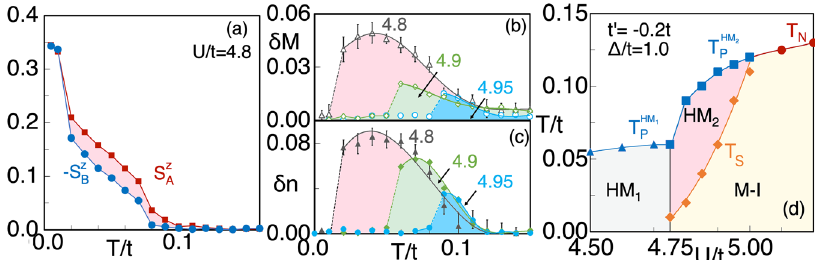
Fig. 3 Magnetism & U − T phase diagram. a It shows the sub-lattice magnetizations S z A and S z B for U / t = 4.8. b , c Show the difference in sub-lattice local moments ( δ M ) and the total spin polarization of the system ( δ n ) respectively, for U / t = 4.8 4.9 and 4.95. In each case, the dashed lines between two temperature points indicate the location of the onset temperature for half-metallicity. d This shows the U − T phase diagram with a low-temperature antiferromagnetic half-metal HM 1 to antiferromagnetic Mott insulator (M-I) transition at U M = 4.75 t . Triangles indicate T P , the depolarization temperature of half metallicity for HM 1 . The red shaded region refers to the fi nite-temperature ferrimagnetic half-metal HM 2 for U M < U < 5 t and bounded by the onset temperature of polarization T S and the depolarization temperature T P . The T S ( T P ) scales for HM 2 are demarcated by diamonds (squares). Circles refer to T N , the temperature above which the M-I state loses long-range antiferromagnetic order. All results are for t 0 = t ¼ (cid:2) 0 : 2, Δ / t = 1.0 and on 32 2 system. Standard deviations in the sub-lattice magnetization in a and the various ordering temperature scales in d are smaller than the symbol sizes; Error bars for U = 4.8 t are generated from standard deviations the sub-lattice local moments in b and spin-resolved densities in c . Error bars for U = 4.9 t and U = 4.95 t are similar in magnitude to that for U = 4.8 t in b and c